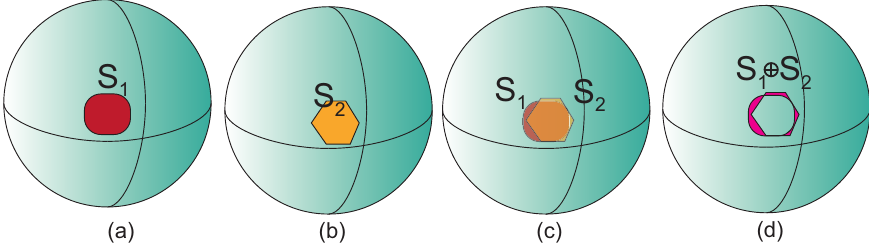
Figure 13. ( a ) S is the subset of points on the sphere enclosed by DGGS1; ( b ) S 1 subset of points on the sphere enclosed by DGGS2; ( c ) S ⊕ S error is S , which is the difference of the areas that are enclosed by S 1 2